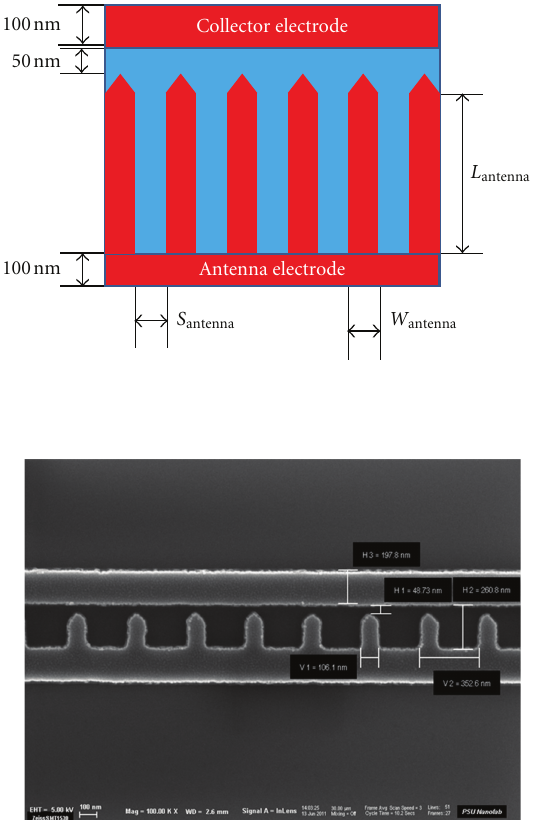
Figure 20: Schematic (top) and SEM image (bottom) of the top view for the columnar antenna with triangular tip.